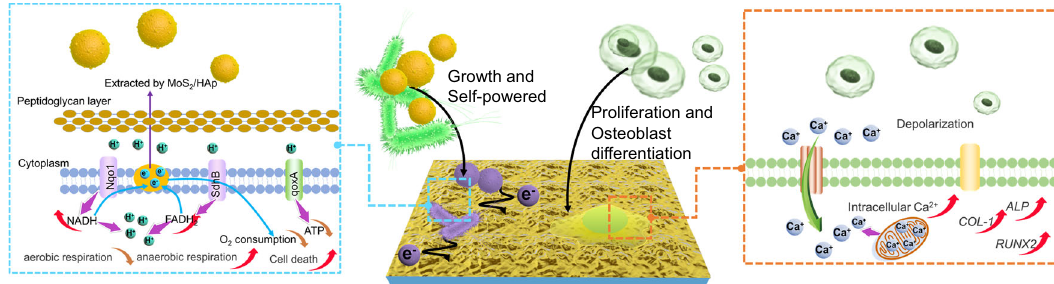
Fig. 1 Design of the bacteria or MSCs – HA/MoS 2 – Ti6 biohybrid system to prevent bacterial infection and improve bone-tissue regeneration simultaneously. Electrons extracting from bacteria to HA/MoS 2 -Ti6 lead to the metabolism pathway changes (left), and the potential of HA/MoS 2 -Ti6 leads to the osteogenic differentiation of MSCs due to upregulated Ca 2 +